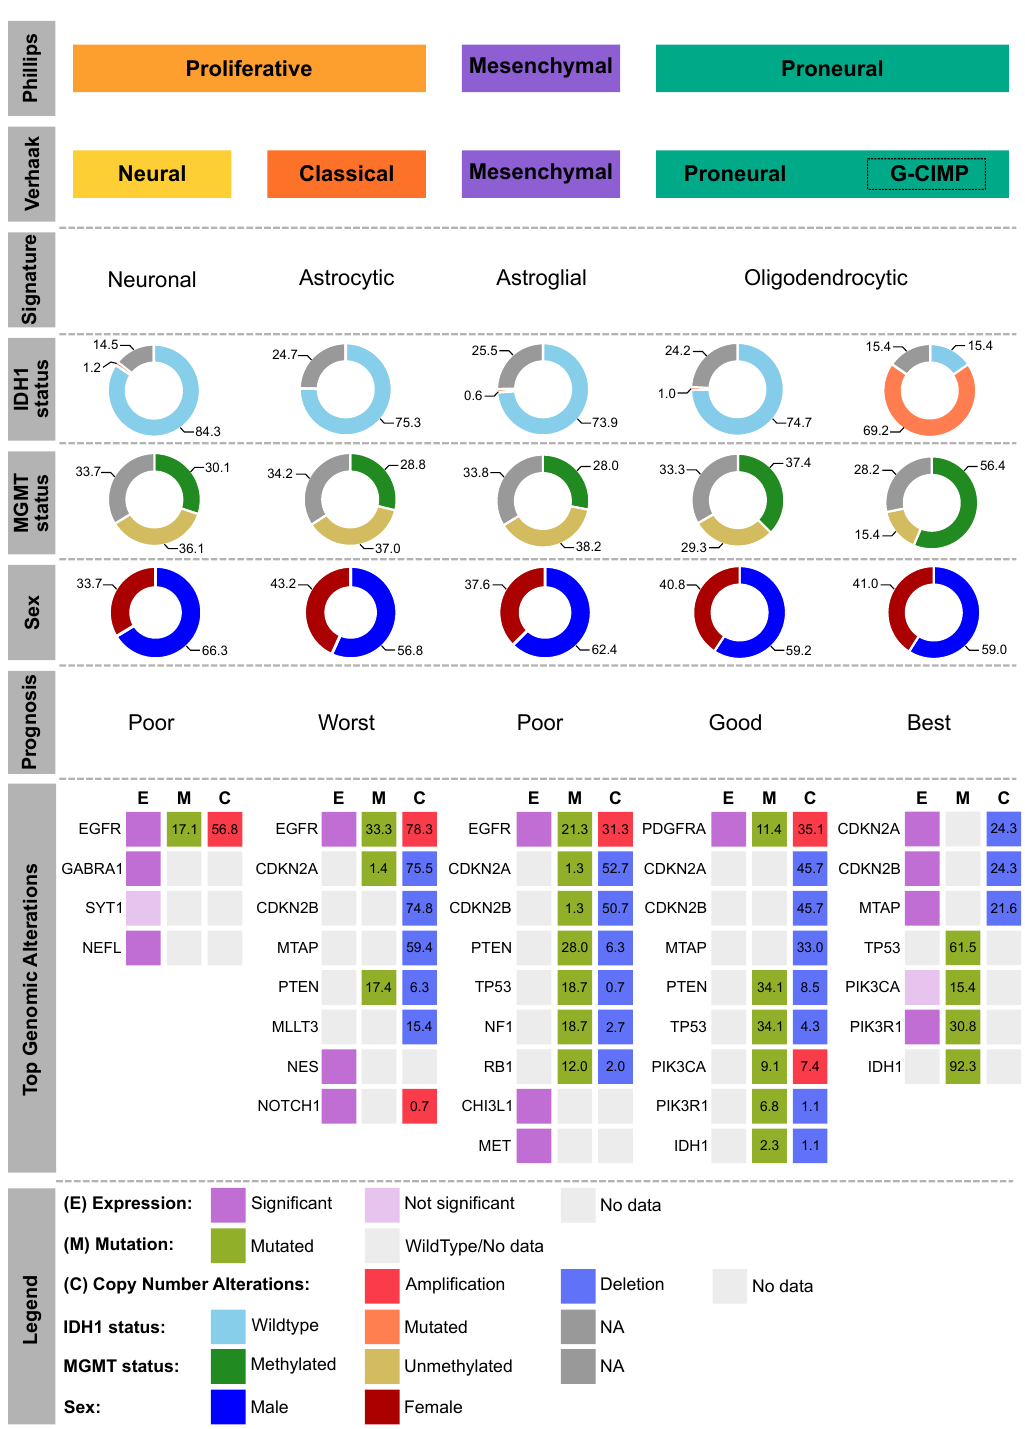
Figure 3. Molecular classification of GBM. GBM tumors in TCGA-GBM dataset originally classified into three (Phillips et al.) [16] or four (Verhaak et al.) [17] distinct subtypes, CL ( n = 146), ME ( n = 157), NE ( n = 83), PN ( n = 99), as well as the glioma-CpG island methylator phenotype (G-CIMP)-positive subset (GC; n = 39), with isocitrate dehydrogenase 1 ( IDH1 ) mutation status, proportion of males and females, and prognosis shown. Top genomic alterations include highly altered genes, i.e., high mRNA expression (magenta), mutation (green), and/or copy number alterations (red: copy number gain; blue: copy number loss), within each subtype and are sorted according to their overall alteration frequencies. Data were generated by the TCGA Analysis Working Group [20], retrieved from cBioPortal for Cancer Genomics (http://cbioportal.org, accessed on 10 August 2020) [21], and donut charts were plotted using the ggplot2 R package